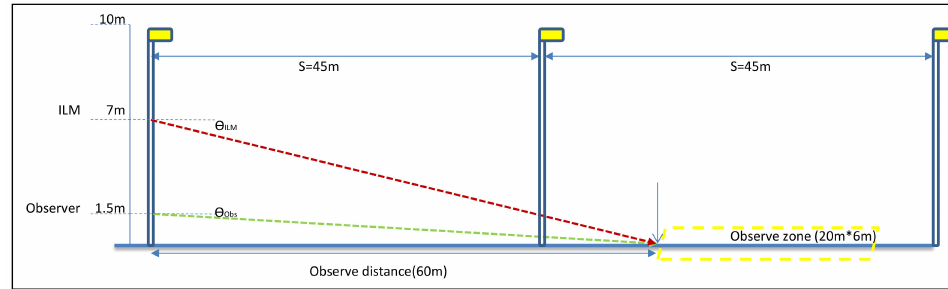
Figure 20. The installation of the